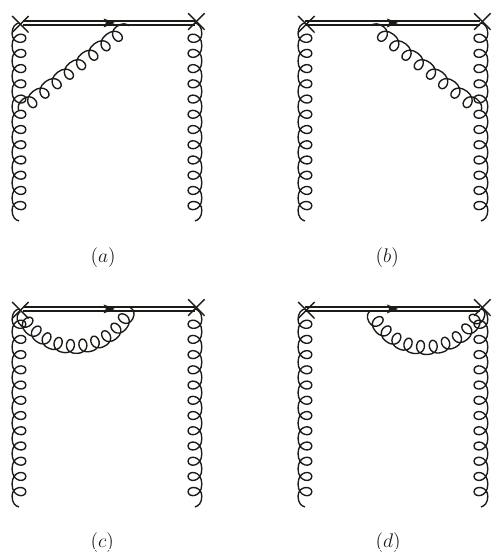
Figure 4 . One-loop corrections to quasi gluon distribution, which involve one Wilson line and connects only one endpoint of internal gluon line. The double line is the Wilson line. The cross “ ” denotes the non-local vertex from the operator structure of ×